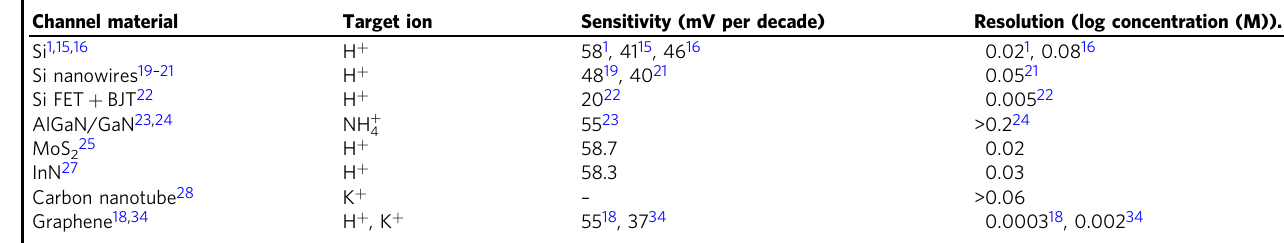
Table 1 Comparison of recent ISFETs in